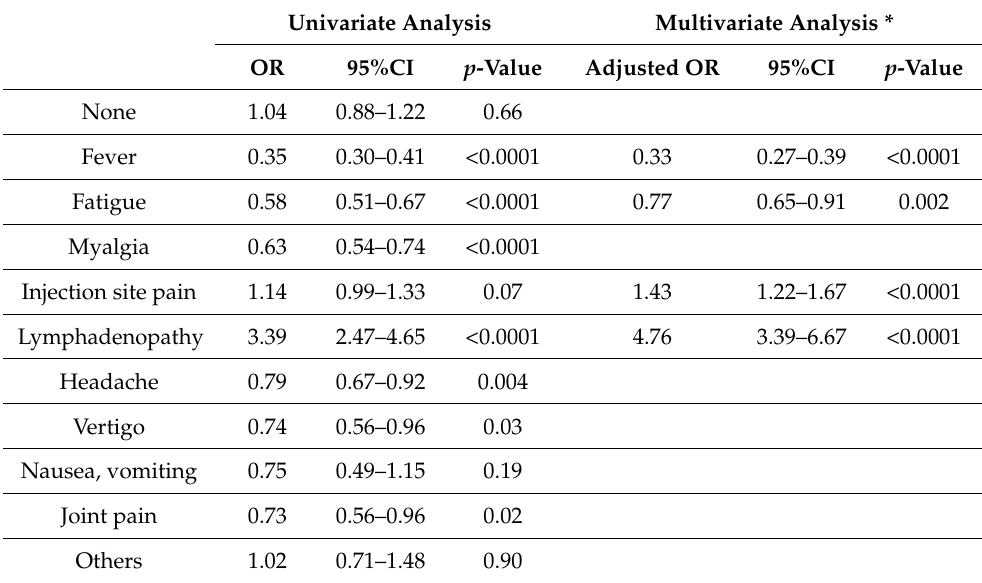
Table 3. Comparison of COVID-19 vaccine side effects between the booster versus the first dose and second dose: bivariate and multivariate analyses.